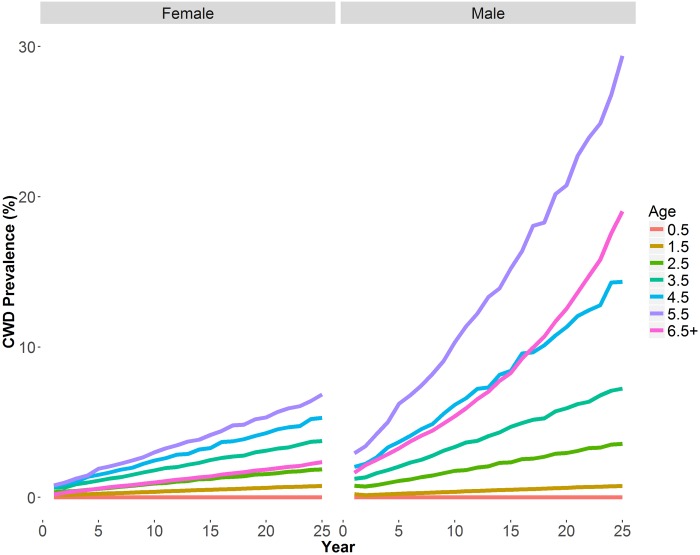
Sex- and age-specific prevalence at the end of simulated years in the slow CWD increase model.Prevalence is the percent of the median number of infected sex- and age-specific deer in the population at the end of each simulated year. Slow CWD started at 1% prevalence and increased annually by 0.26%.